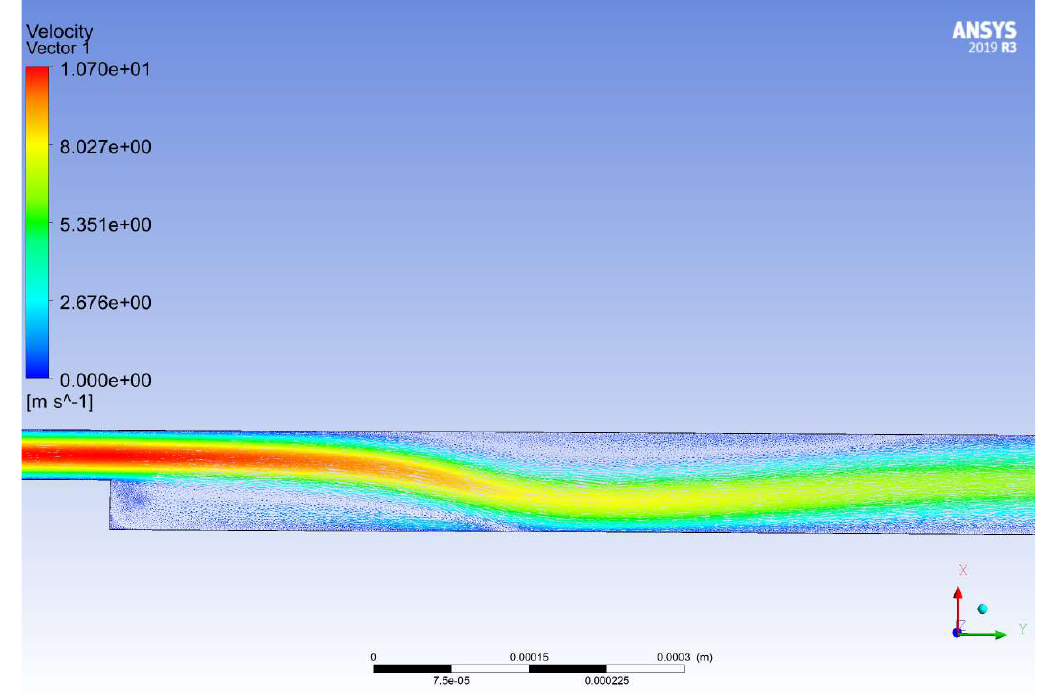
Figure 15. Velocity vector distribution in the Reynolds Stress turbulence model.